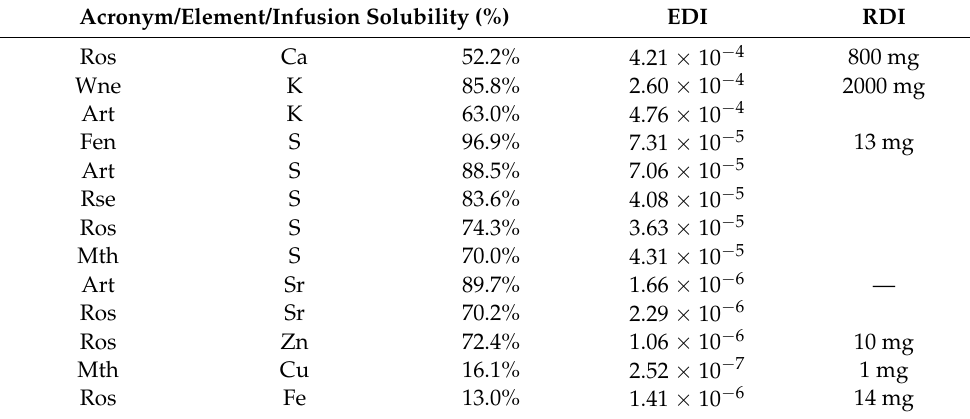
Table 5. Estimated daily intake (EDI) expressed in mg/kg bw/day.